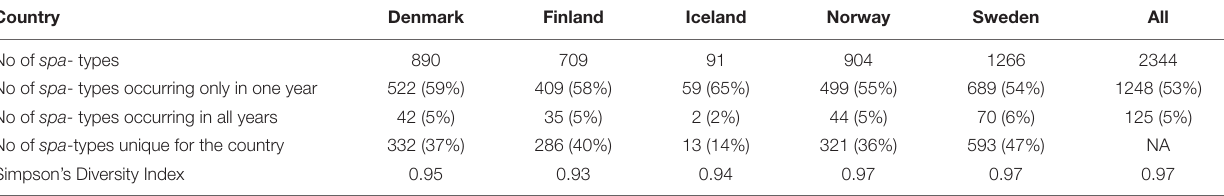
TABLE 2 | Diversity of spa- types among MRSA in the Nordic countries 2009-2016. Country Denmark